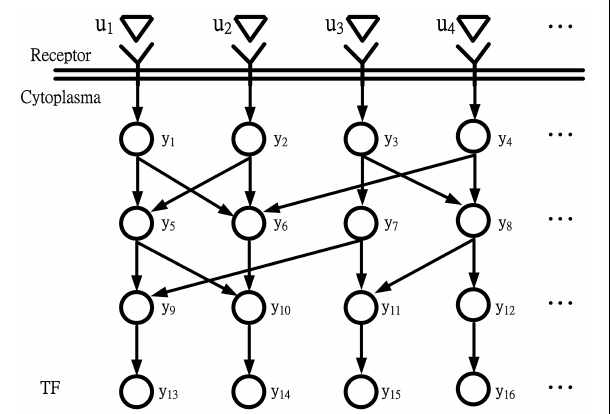
FIGURE 1 | Information flow chart depicting coupling signal transduction pathways that control gene activities. u 1 , u 2 , u 3 , and u 4 are extracellular signals; y 13 , y 14 , y 15 , and y 16 are expression levels of